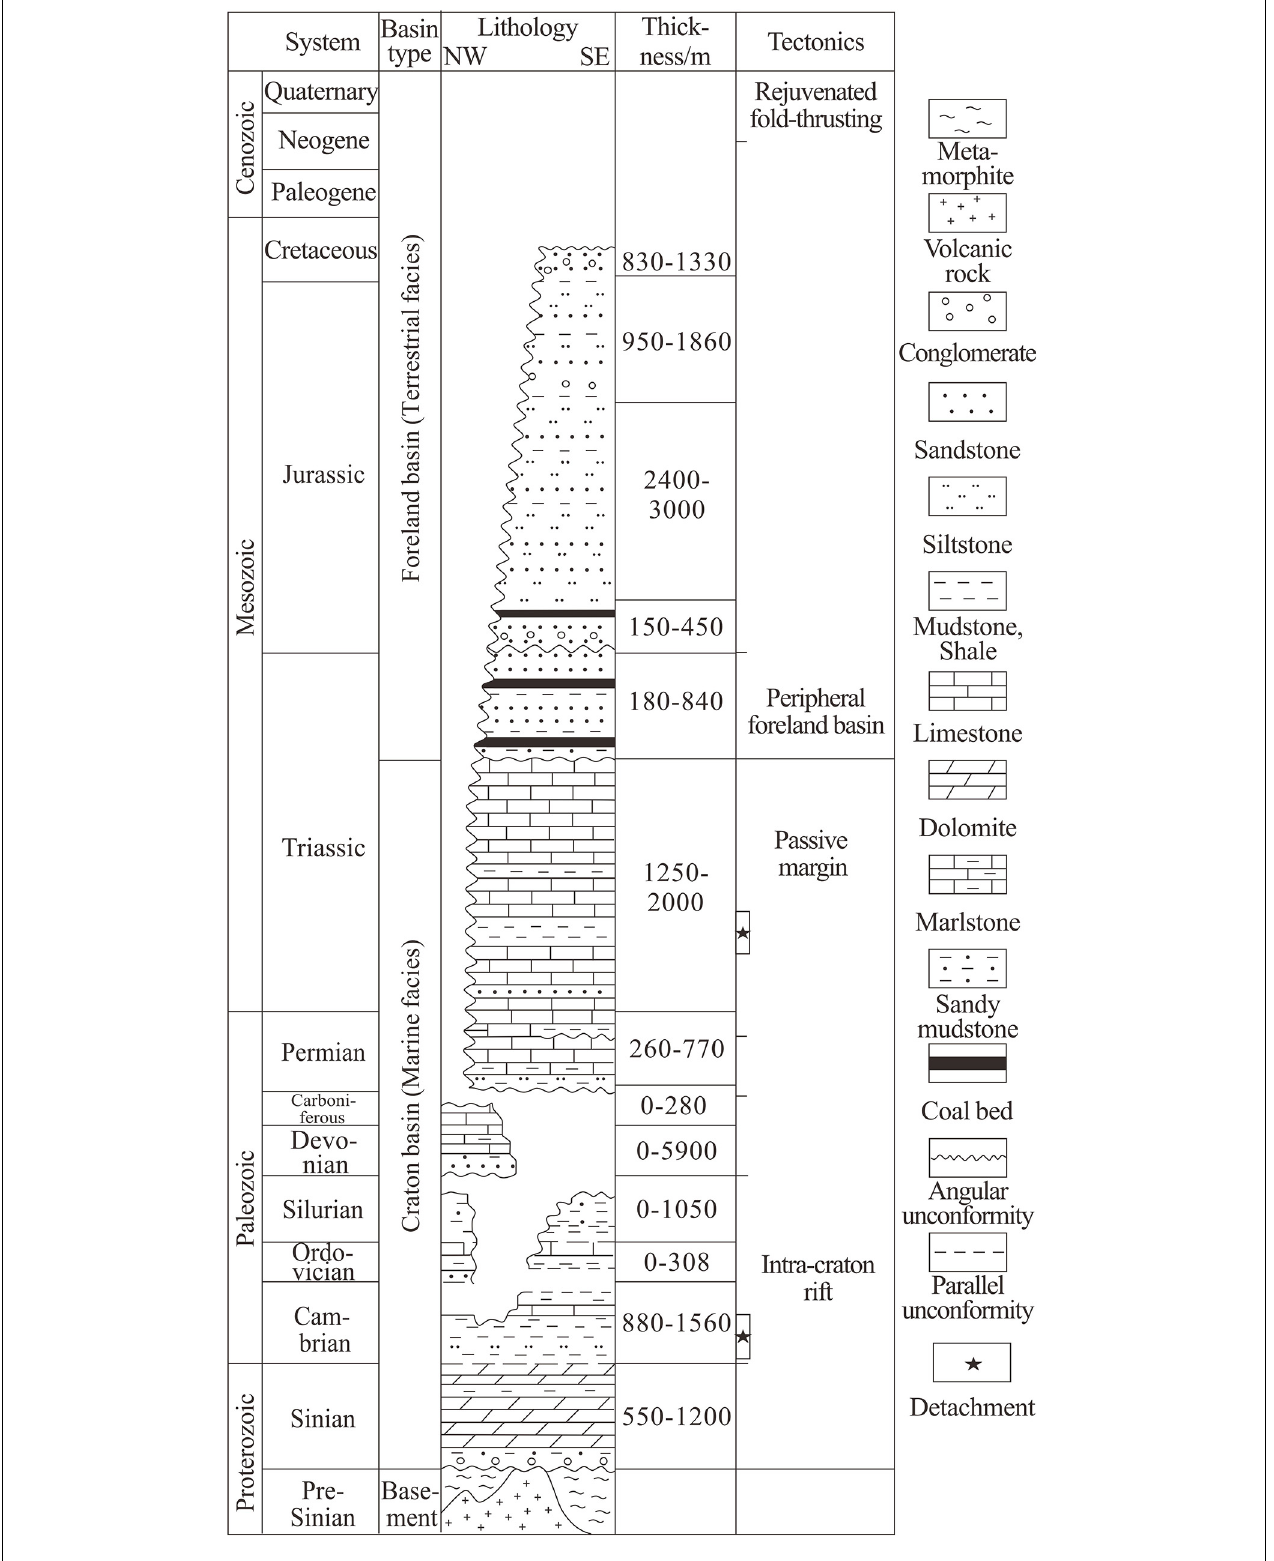
FIGURE 2 | Simplified stratigraphic column of the NW Sichuan Basin, showing multistage tectonic activities. Modified from Chen et al. (2019).